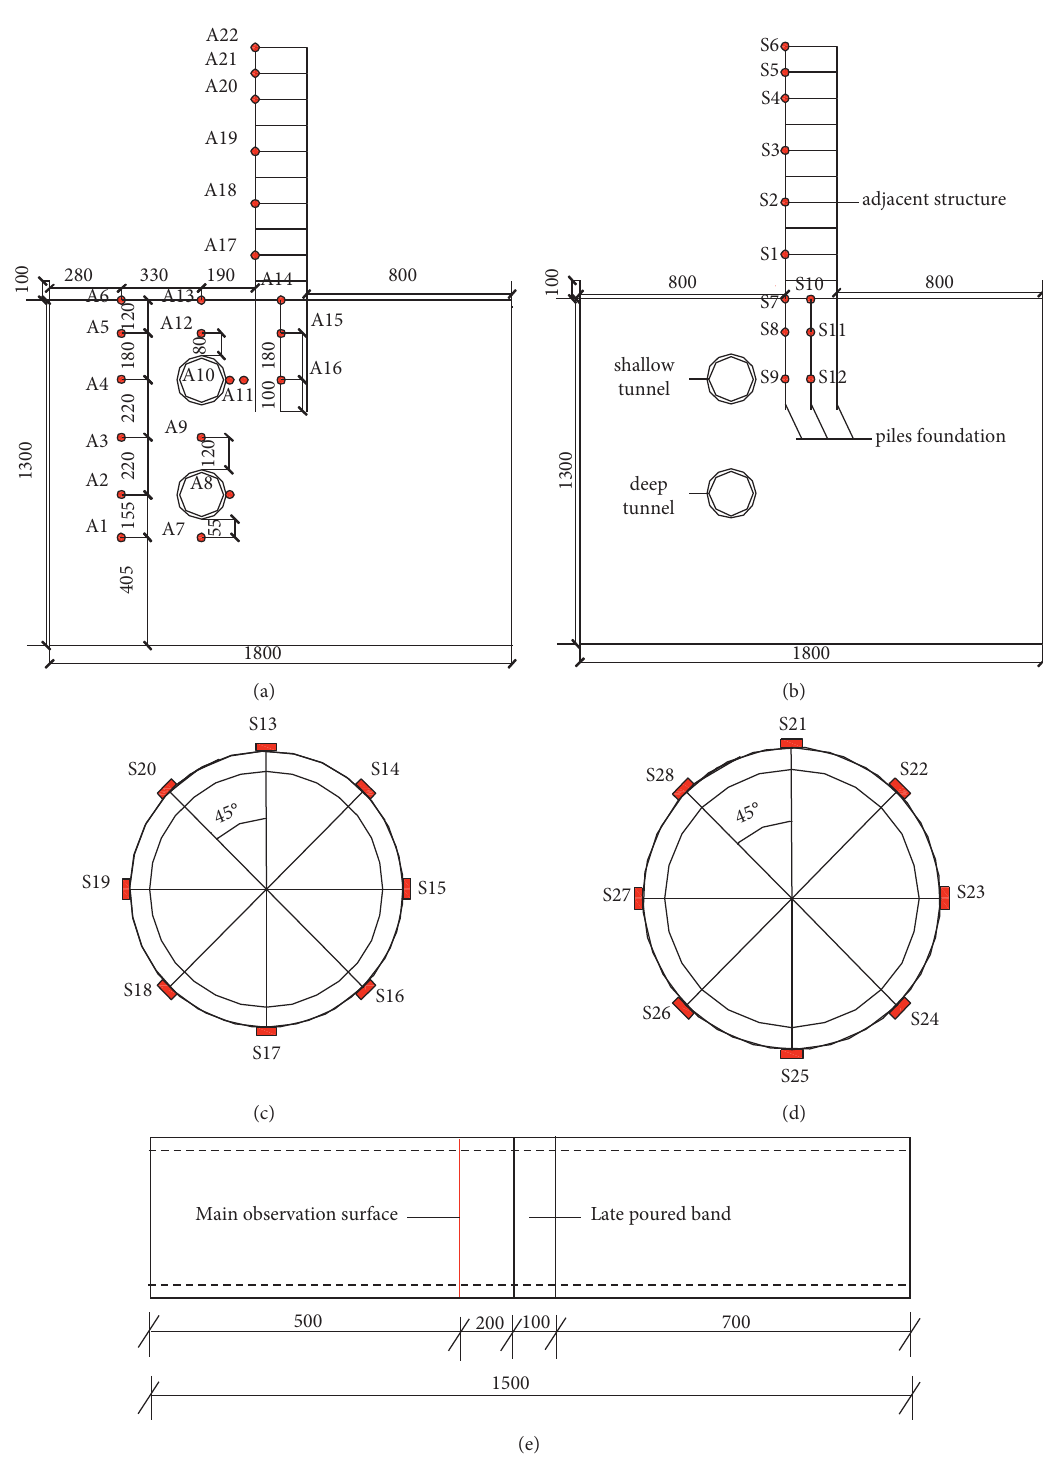
Figure 4: Layouts of sensors in the soil, surface structure, and tunnel (unit: mm). (a) Accelerometers of system. (b) Strain gauges of surface structure. (c) Strain gauges of the shallow tunnel. (d) Strain gauges of the deep tunnel. (e) Main observation surface of